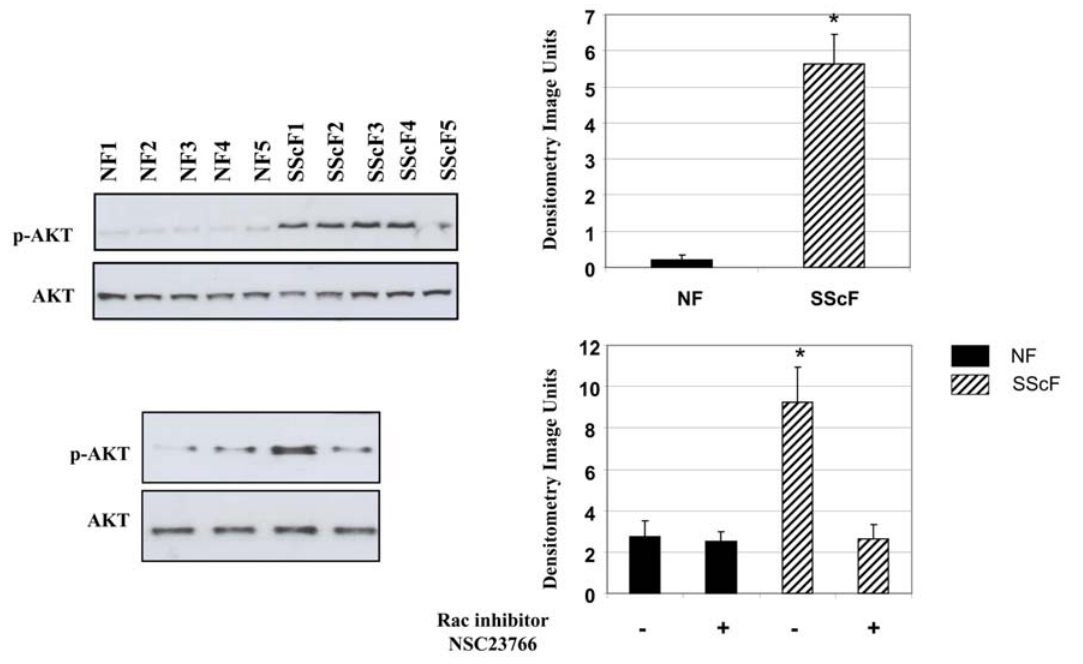
Figure 6. Akt phosphorylation is elevated in dermal fibroblasts and is reduced by rac inhibition. Whole cell lysates were subjected to SDS/PAGE and Western blot analysis with an anti-phospho Akt and anti-Akt antibodies in the absence (TOP PANEL) or presence or absence (BOTTOM PANEL) of 50 m M NSC23766. Quantitative densitometry data is indicated on the right. Experiments were performed on cells derived from 6 normal individuals and 6 SSc patients. Quantitative densitometry data is indicated on the right (*=p , 0.05 relative to wild-type control).